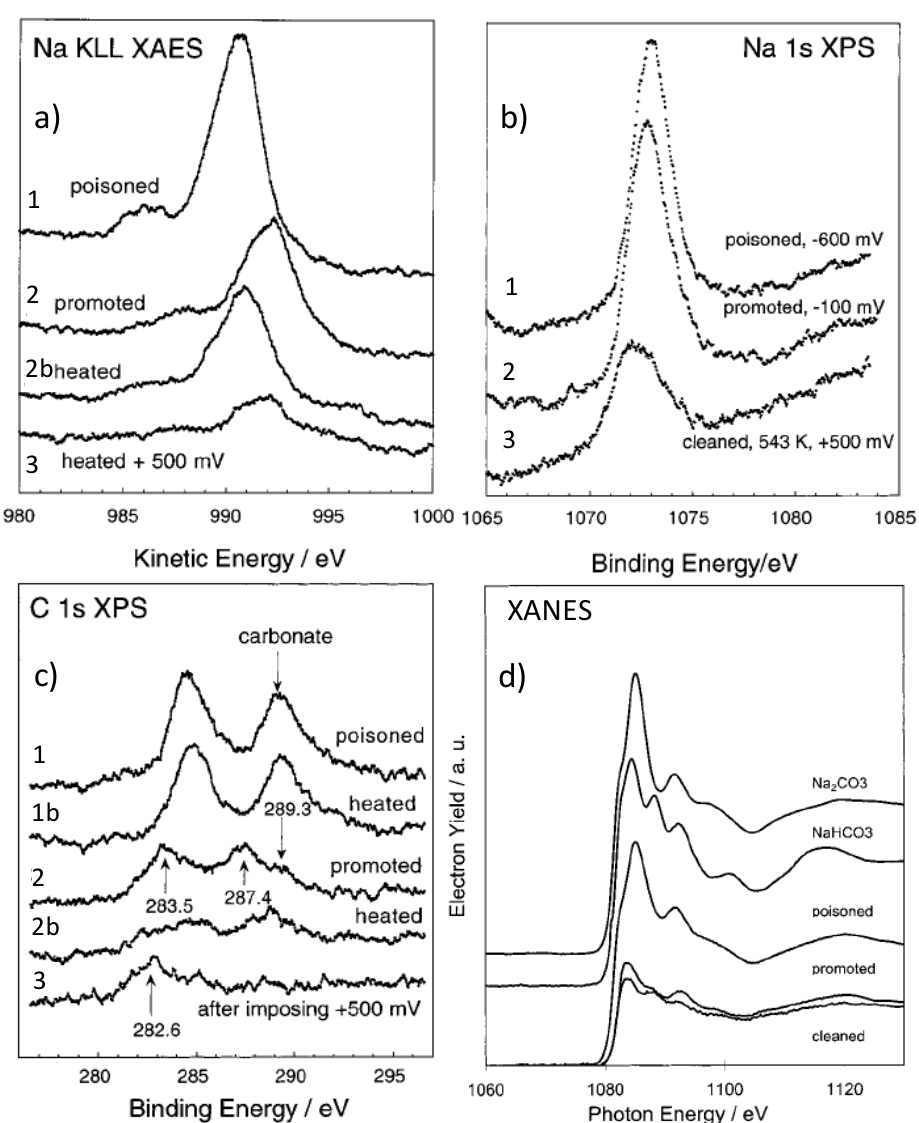
Figure 6. ( a ) Sodium KLL XAES, ( b ) Sodium 1s XPS and ( c ) Carbon 1s XPS analysis of a Pt/Na- β Al 2 O 3 electrochemical catalyst under propene combustion atmosphere (0.6 kPa propene, 2.5 kPa oxygen). All spectra acquired at room temperature, open circuit, after exposure to different un-promoted and electropromoted conditions: 1 , poisoned conditions, V WR = − 600 mV; 1b , as 1 but after heating to 588 K; 2 , promoted conditions, V WR = − 100 mV; 2b , as 2 but after heating to 588 K; 3 , as 2 but after imposing V WR = +500 mV. (d) XANES spectra after exposure to propene and oxygen at 500 K under promoted and poisoned conditions (See Ref. [37] for temperature and partial pressures conditions). Reference XANES spectra for the cleaned surface, Na 2 CO 3 and NaHCO 3 are also shown. Reprinted with permission from Ref. [37].